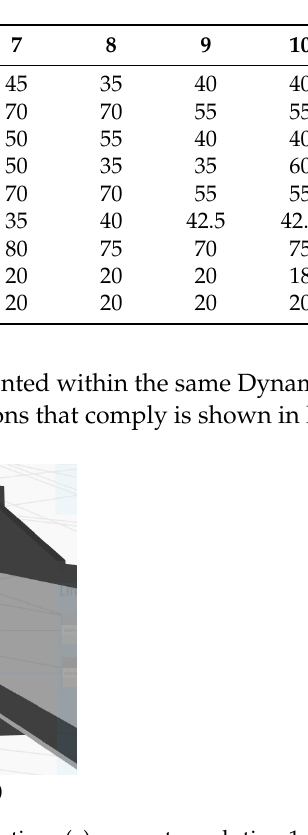
Table 5. Solution input variables in mm. Source: the authors.